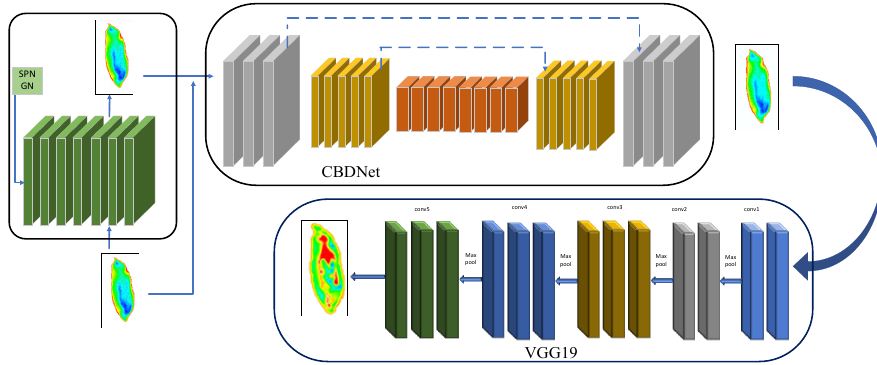
Figure 3. The terahertz spectral image enhancement model for unsound kernels of wheat.